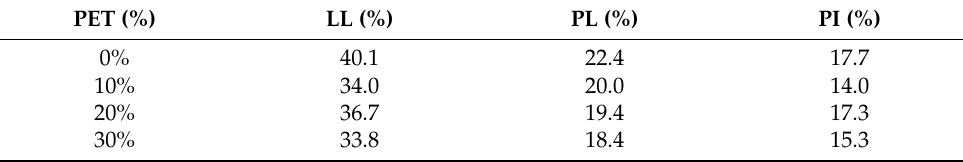
Table 2. Sample consistency